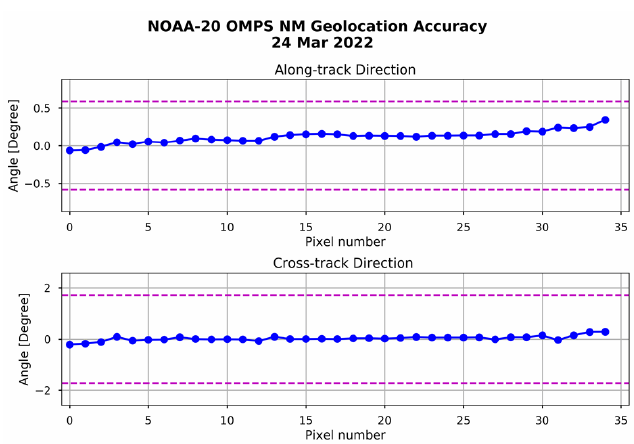
Figure 14. Same as Figure 13 but for SNPP OMPS-NM.